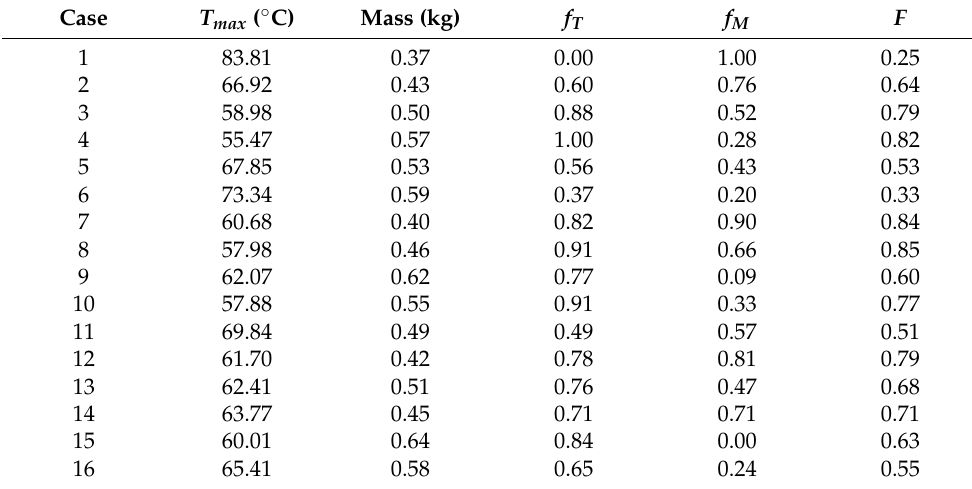
Table 6. Integrated performance analysis.